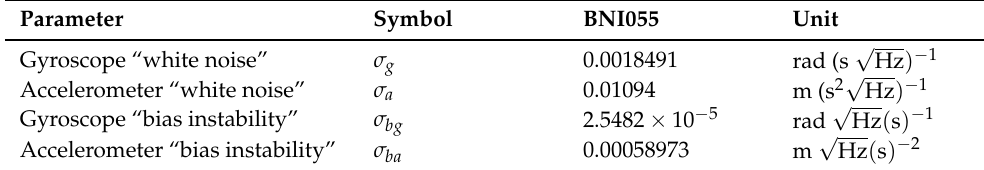
Table 1. Gyroscope and accelerometer calibration parameters. Equations are derived in [34].